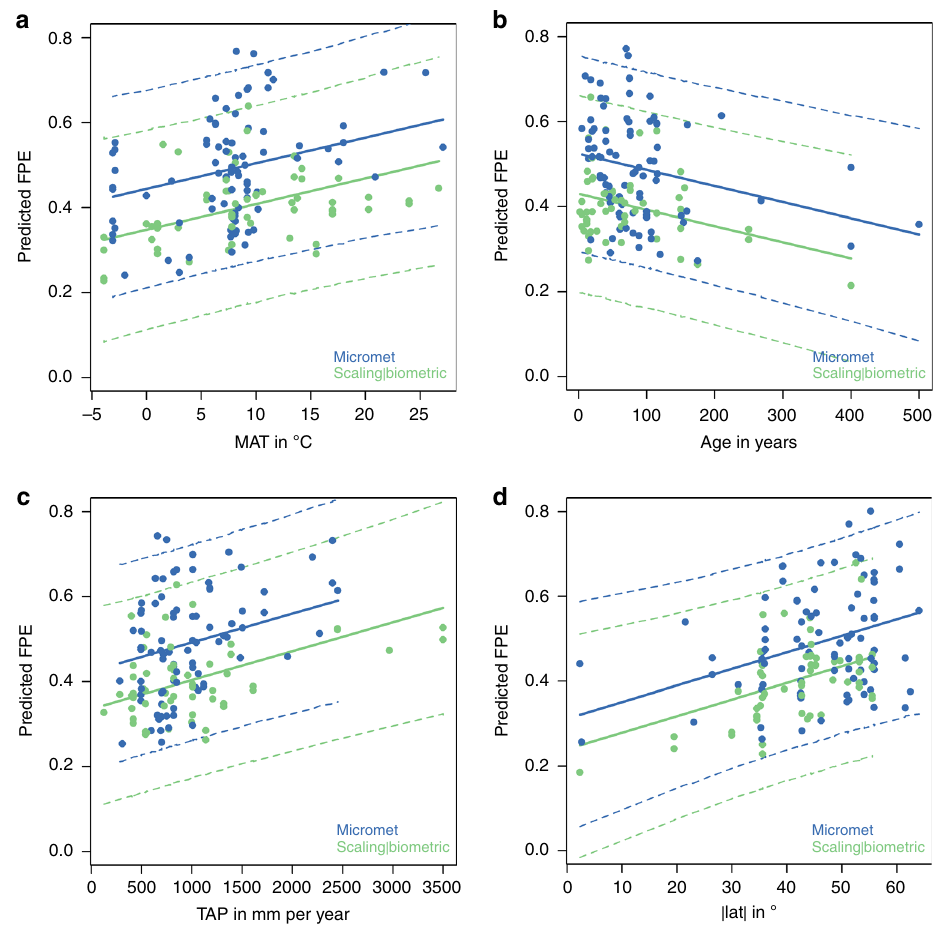
Fig. 4 Predicted FPE vs. single effects of environmental and structural variables. Predictions of the mixed linear model for single fi xed effects (Eq. (1)), given the other independent variables constant at their average values for that GPP method category. The dashed lines represent con fi dence intervals at the 0.05 and 0.95 levels calculated with the function ‘ predict Interval ’ of the R-package ‘ merTools ’ . Table 1 Parameters of the mixed-effects multiple regression model (Eq. (1)).